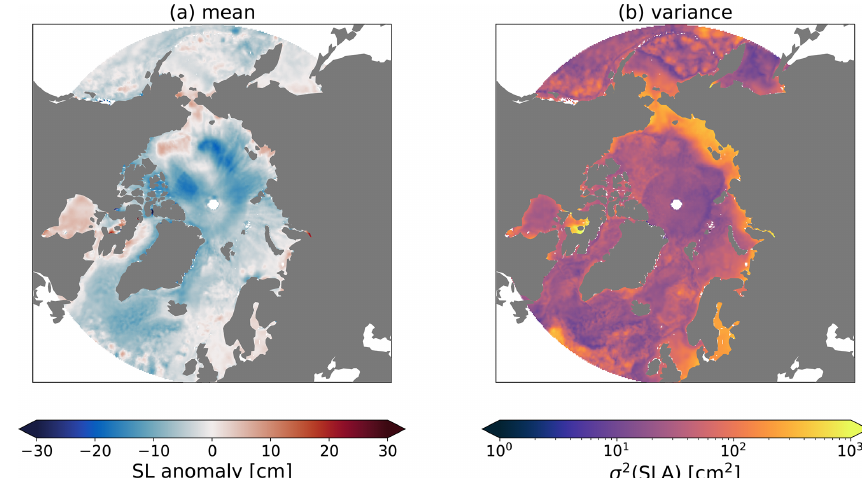
Figure 7. Maps of (a) mean SL and (b) variance of SL in the Arctic Ocean from the combined product.